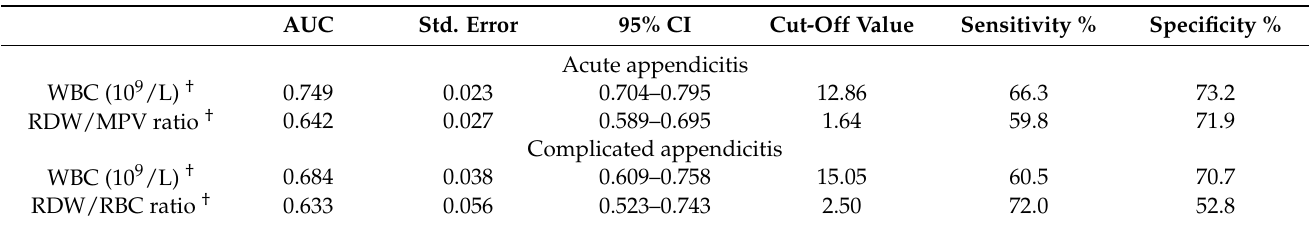
Table 3. Proposed cut-off values for significant parameters in the diagnosis of acute appendicitis, and complicated appendicitis. AUC Std. Error 95% CI Cut-Off Value Sensitivity % Specificity